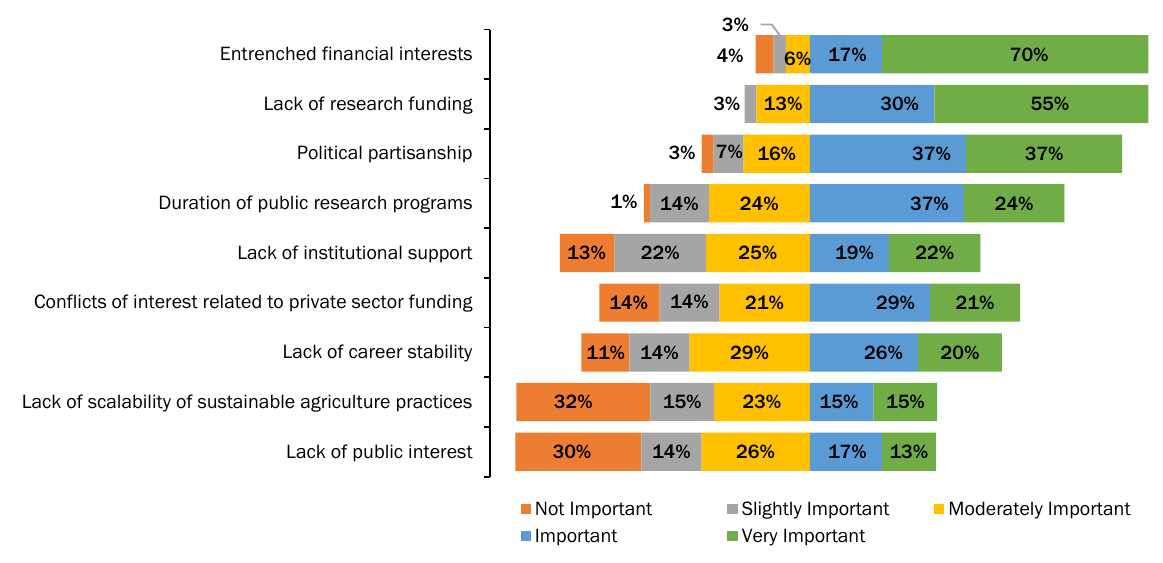
Figure 1. Perceptions of Obstacles to Sustainable Agriculture Research ( N =71)